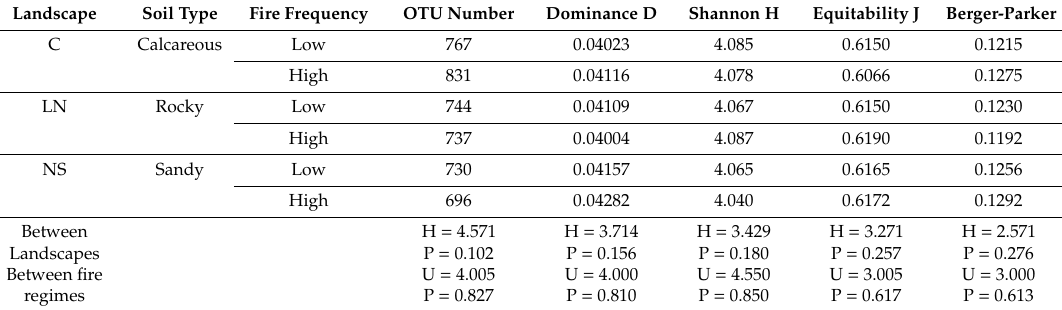
Table 2. Bacterial diversity in soils. Lanscape codes follow Table 1. Statistical results are shown between soil types (H, Kruskal–Wallis test) and between fire regimes (U, Mann–Whitney test) and their respective significance values